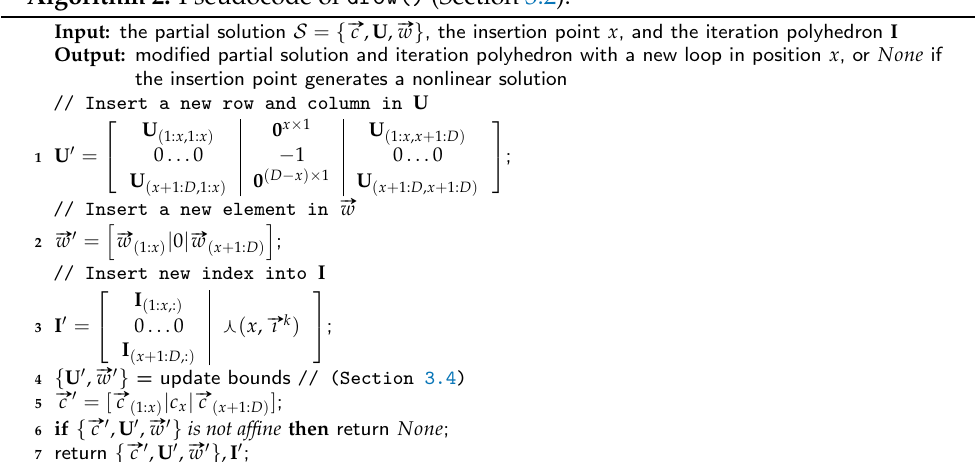
Algorithm 2: Pseudocode of Grow() (Section